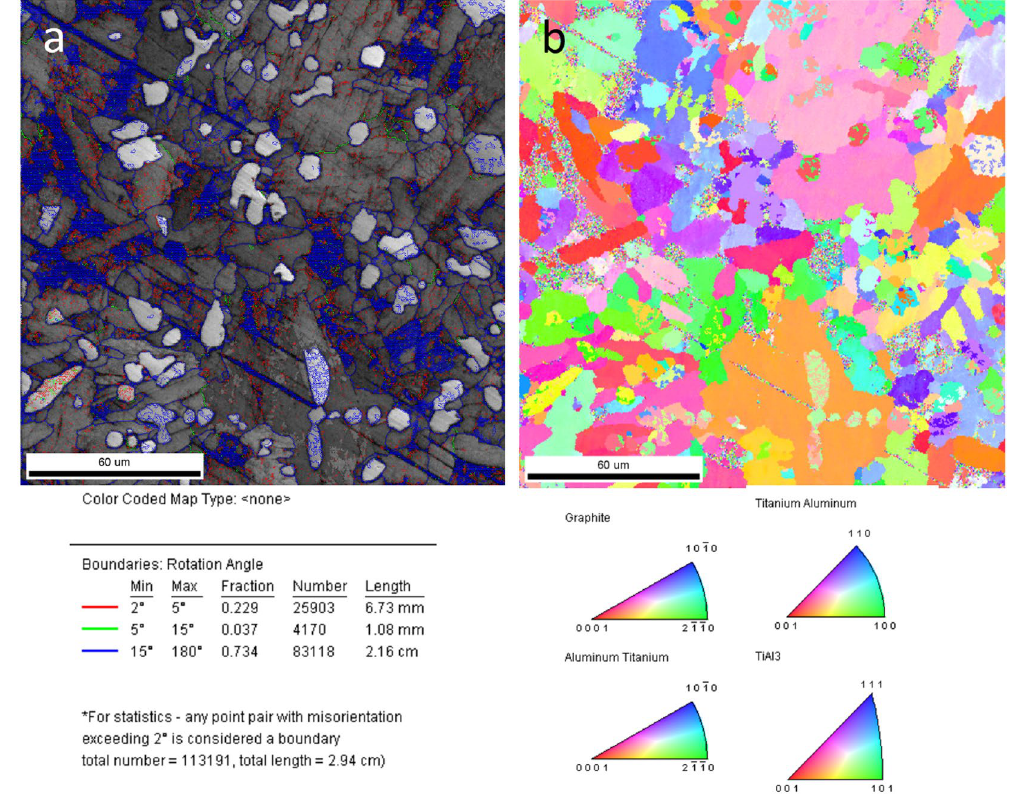
Figure 4. EBSD patterns of final CFGRTAC. ( a ) Microstructure and statistical regularity of rotation angles in grains boundaries. ( b ) Microstructure and phase distribution of CFGRTAC.